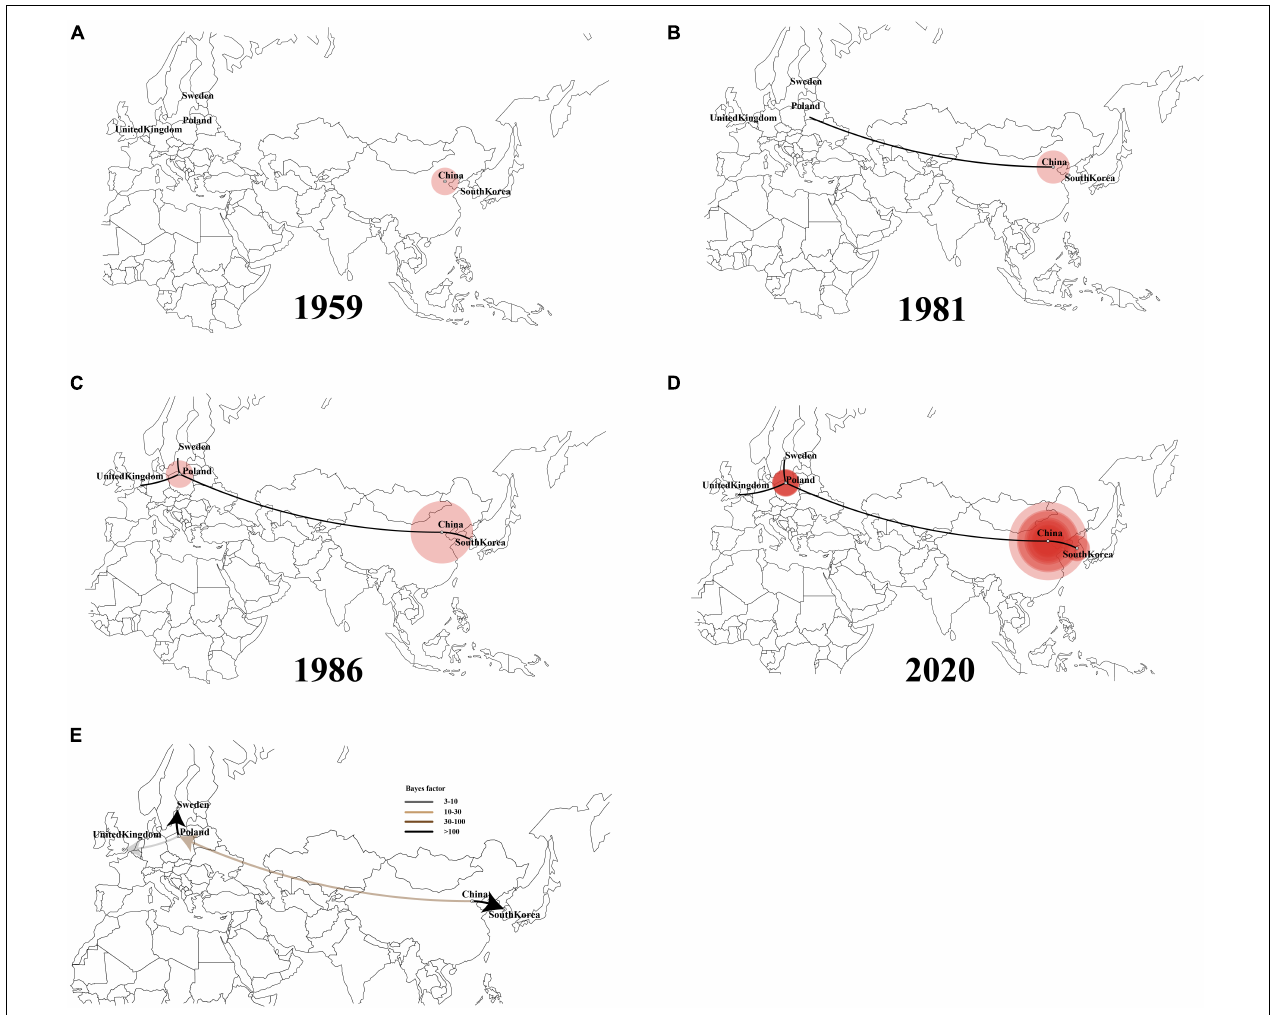
FIGURE 7 | Spatiotemporal dynamics of LX4-type infectious bronchitis virus (IBV) isolates among different localities (A–D) . Bayes factor (BF) test for significant non-zero rates and regional transmission analysis (E) . Curves show the among-country virus lineage transitions statistically supported with Bayes factor > 3 for all the LX4 genotype IBV isolates in the